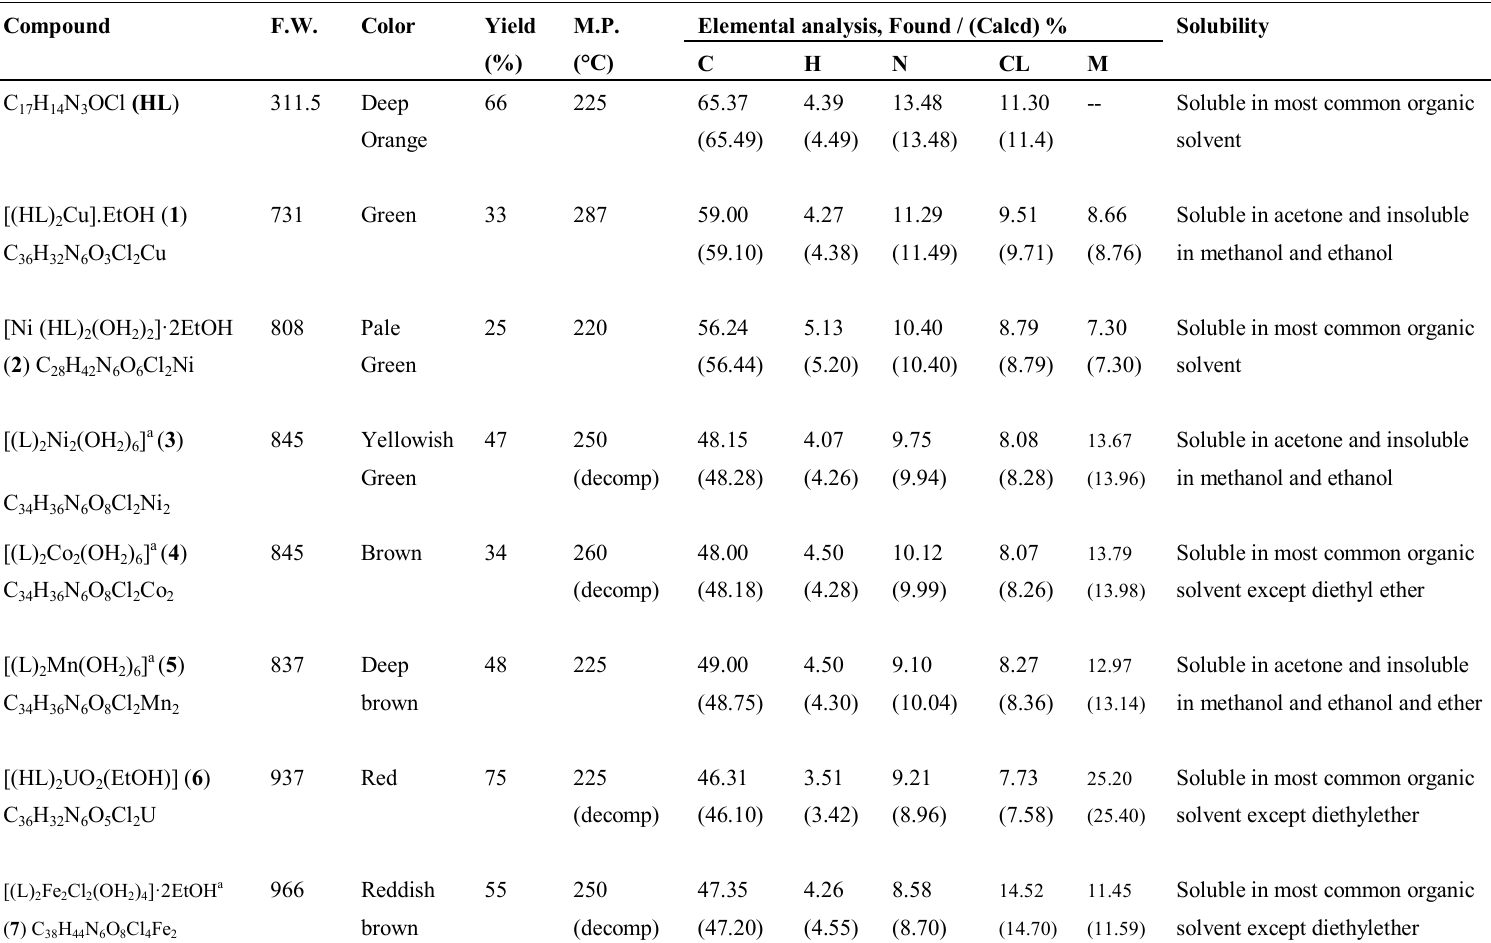
Table 1. Elemental analyses, color, yield, melting points and molar conductance of HL and its corresponding metal complexes.